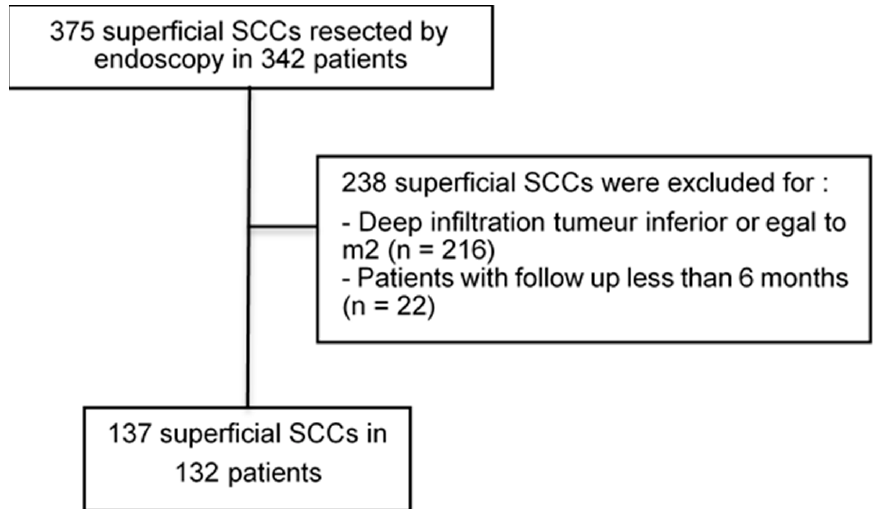
Figure 1. Flow chart of tumors that underwent esophageal endoscopic resection. SCC, squamous cell carcinoma; m2, intramucosal invasive carcinoma limited to the lamina propria mucosae.